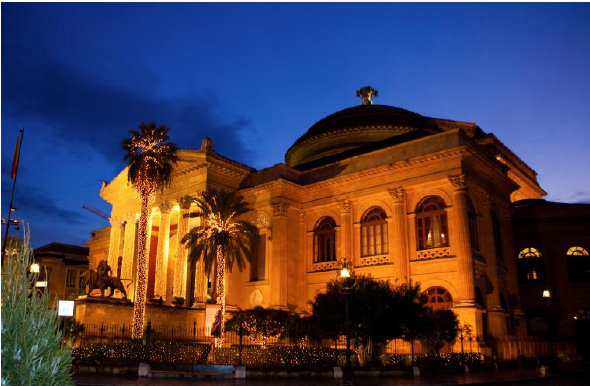
Figure 1. The Teatro Massimo